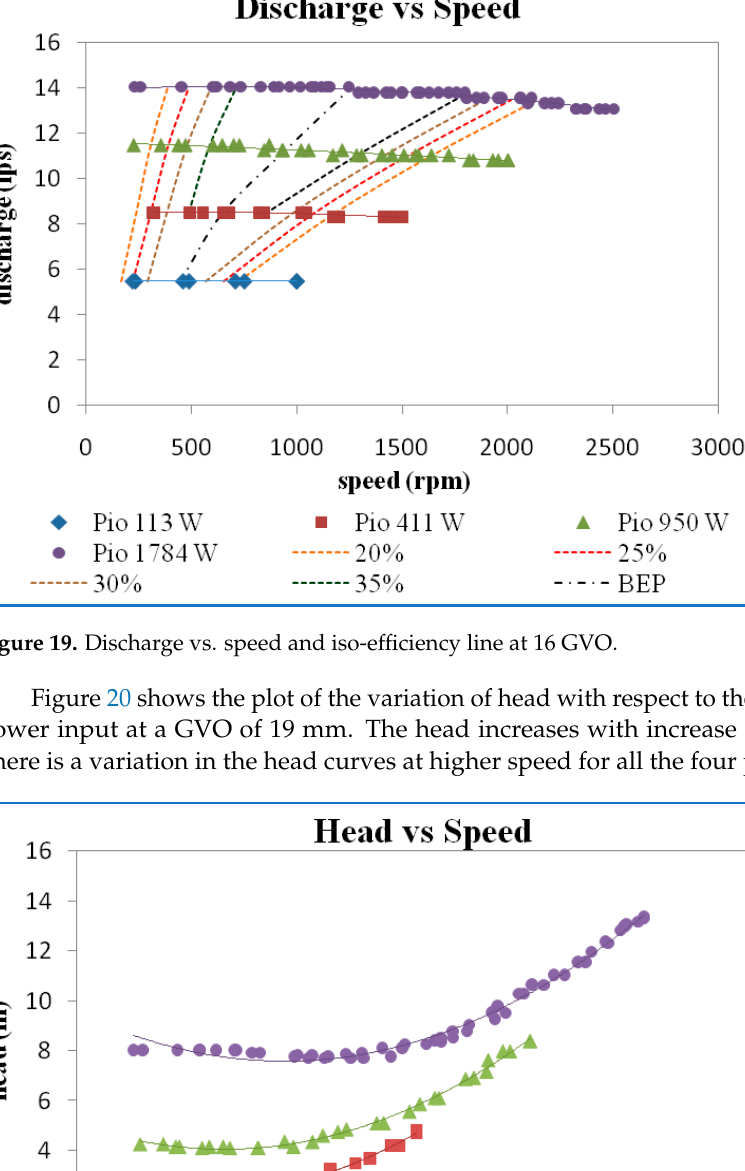
Figure 20. Head vs. speed at a guide vane opening of 19 mm.